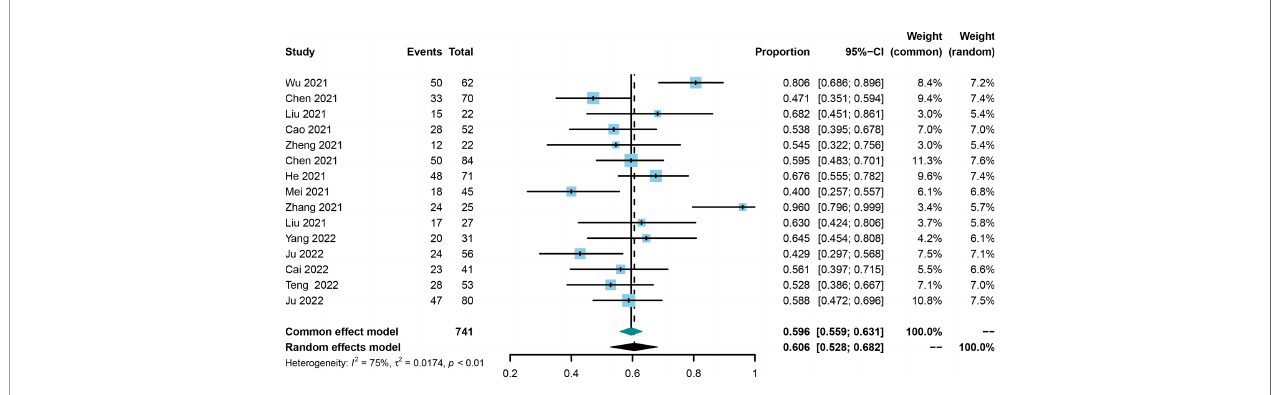
FIGURE 3 | Forest plot of the pooled objective response rate.